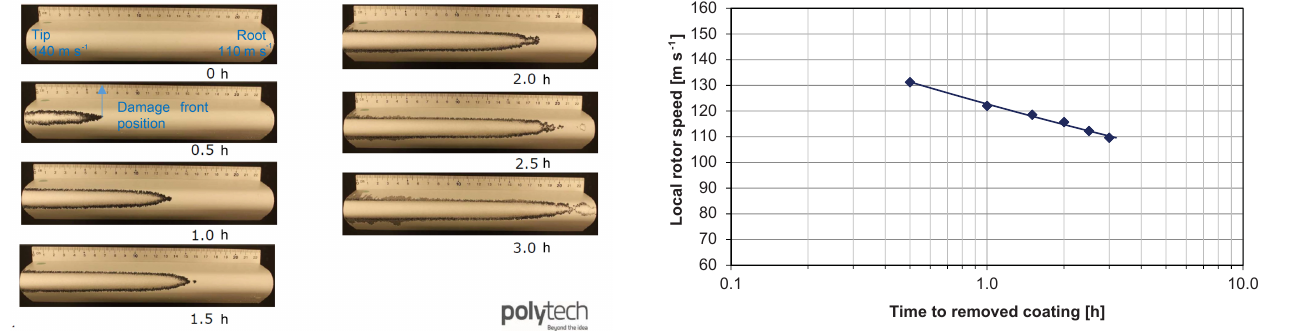
Figure 2. Whirling arm rain erosion test specimen photographed at 30min intervals during 3h of testing.